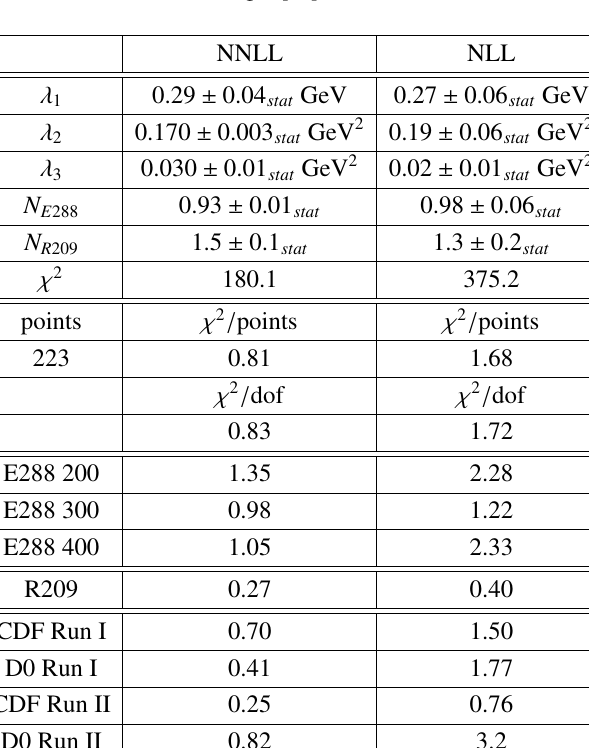
Table 2. Results of our global fit on low-energy [16, 18] and Tevatron data [19–23], with D NP (cid:2) 0 (Eq. (9)), Q i = Q 0 + q T , at NNLL and NNL accuracies and with the collinear parton distributions from CTEQ10 [27] at NNLO and NLO.